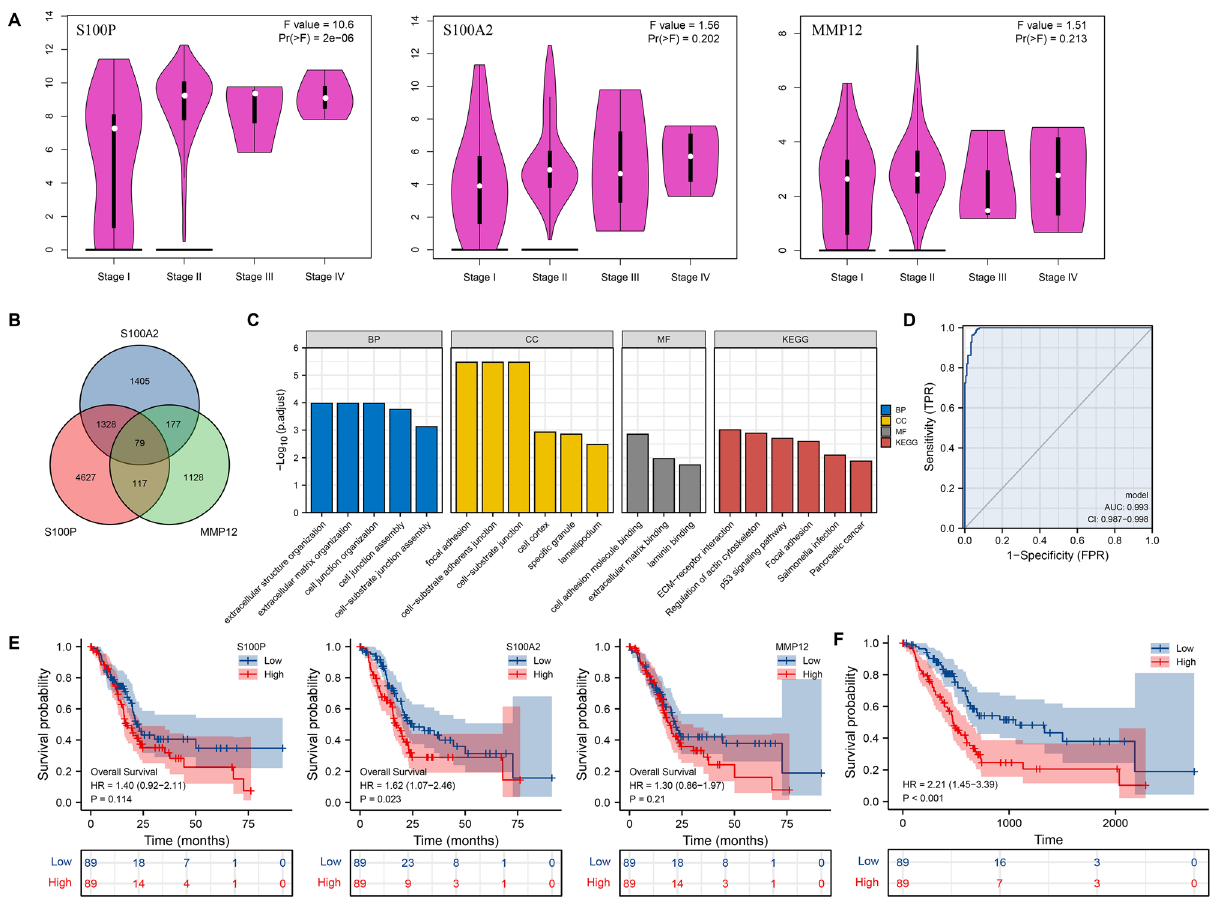
Figure 4. A comprehensive evaluation of IRGS. ( A ) Expression of 3 signature genes in different pathologic stages of PAAD; ( B ) Venn diagram of intersection of enrichment analysis of 3 signature genes; ( C ) GO and KEGG analysis of 3 signature genes; ( D ) diagnostic value of IRGS in PAAD; ( E ) single-gene survival analysis of OS was shown in Kaplan–Meier curves respectively; ( F ) Kaplan–Meier curves show that OS was significantly different between the low- and high-risk groups in TCGA-PAAD. OS overall survival; * P < 0.05, ** P < 0.01, *** P <